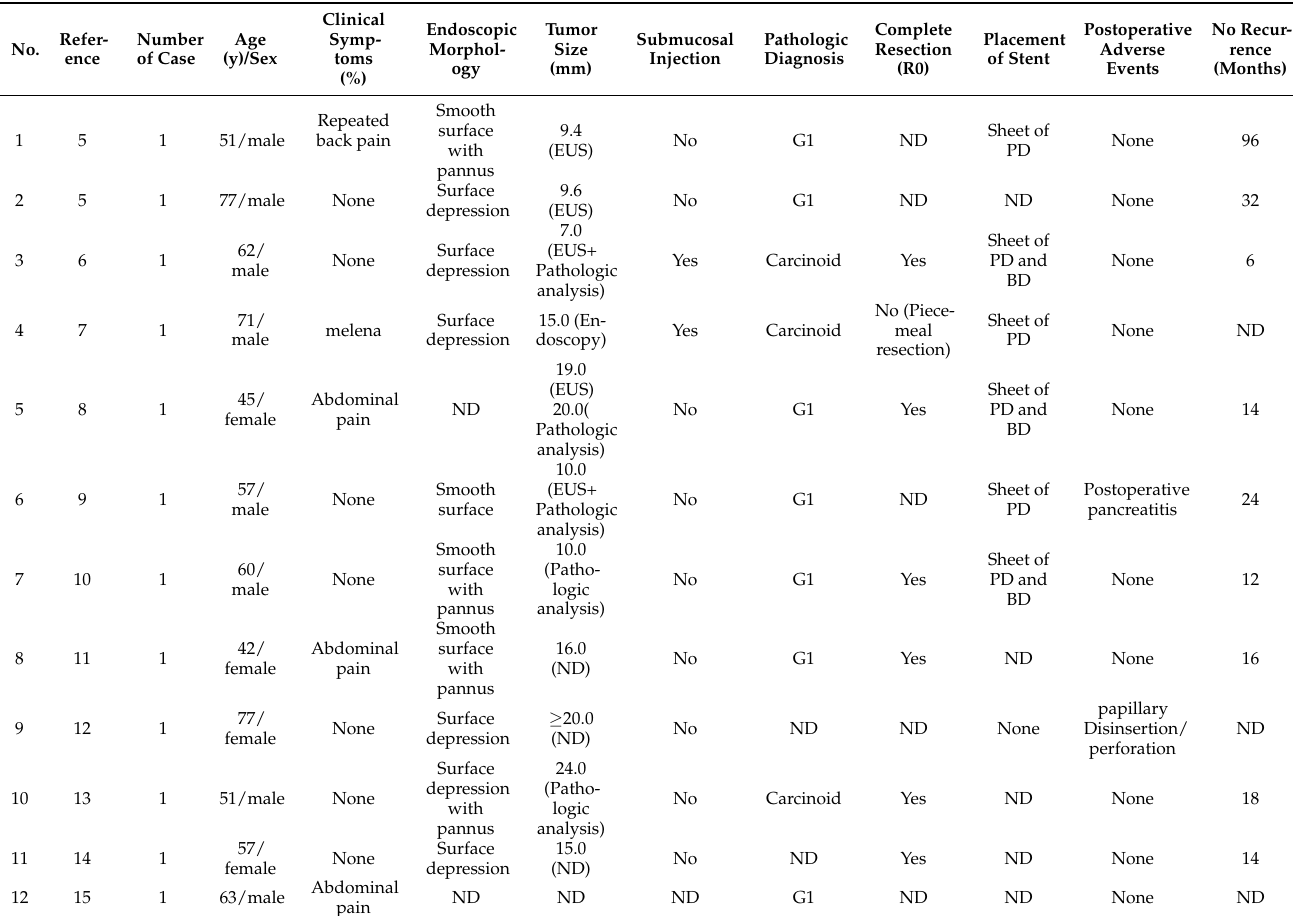
Table 2. Clinical characteristics and outcomes for patients with ampullary neuroendocrine tumors after endoscopic papillectomy (from published